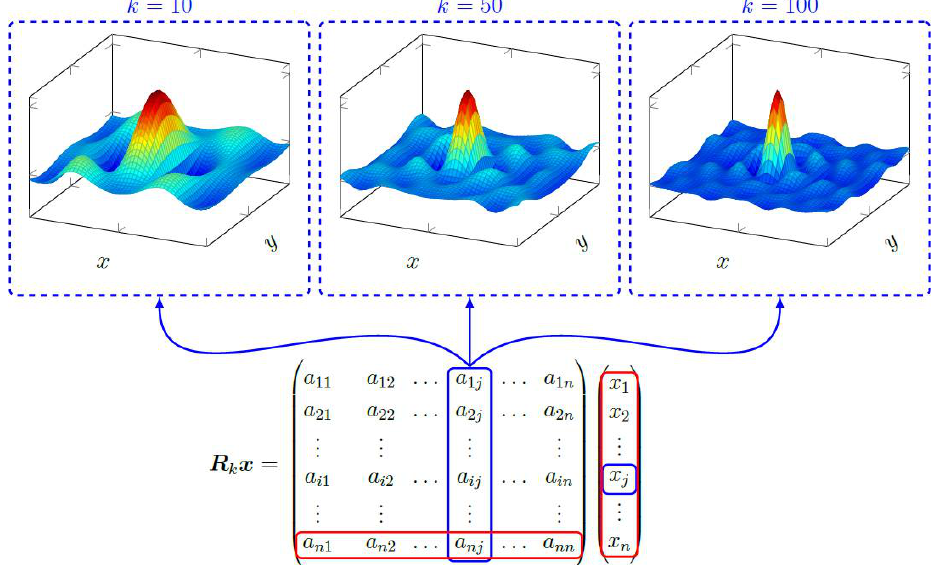
Figure A1. The columns of the resolution matrix R k reflects the spread of a delta-like input, which can be thought of as the Point-Spread Function of the system. For the inverse operator for different iterations k , the resolution matrix attains a more delta-like response, which means that the spread is reduced and that resolution is enhanced The peaks as shown in Figure A1 become narrower with increasing iteration